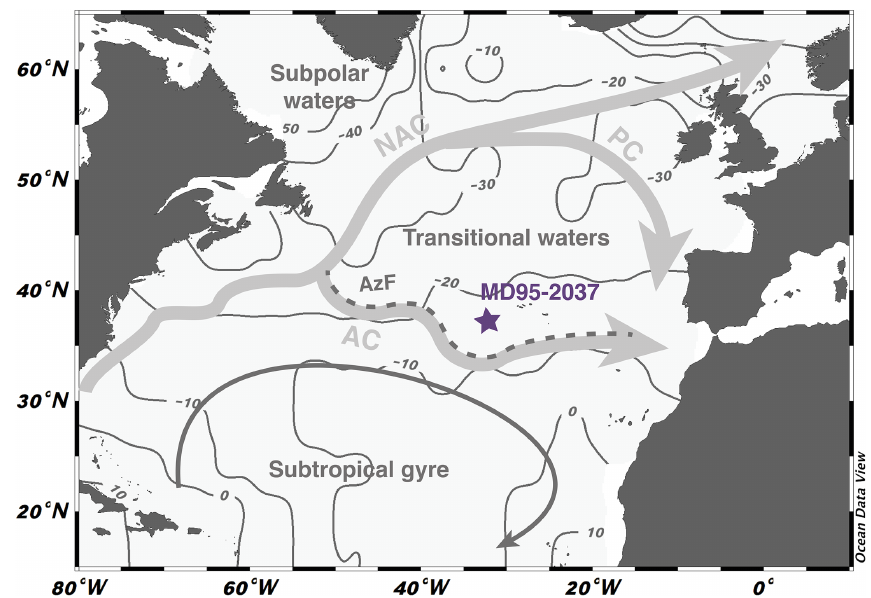
Figure 1. Location and hydrological settings of core MD95-2037. The core lies north of the Azores Current (AC) and the associated Azores Front (AzF), a branch of the North Atlantic Current (NAC). It is located in the transitional waters delimited to the north by the Portugal Current (PC). Site location overlays a map of mean annual (cid:49) pCO 2 (in ppm, Takahashi et al., 2011) compiled with the Ocean Data View software (http://odv.awi.de, Schlitzer, 2018). Regions with positive (negative) values are sources (sinks) for atmospheric CO 2